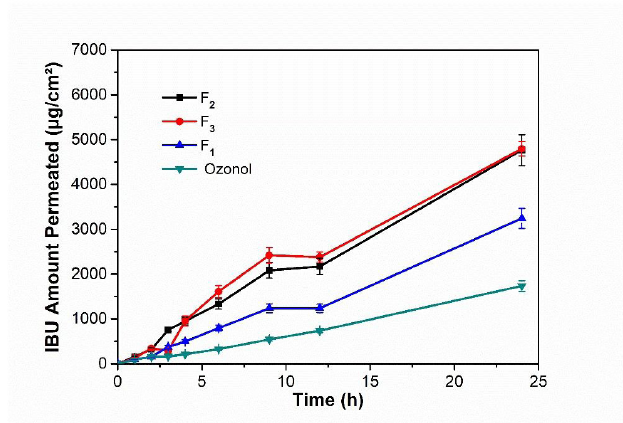
FIGURE 2 - In vitro permeation profiles of IBU from patch formulations. The results are expressed as mean ± SEM (n=6) * p < 0.05 vs .